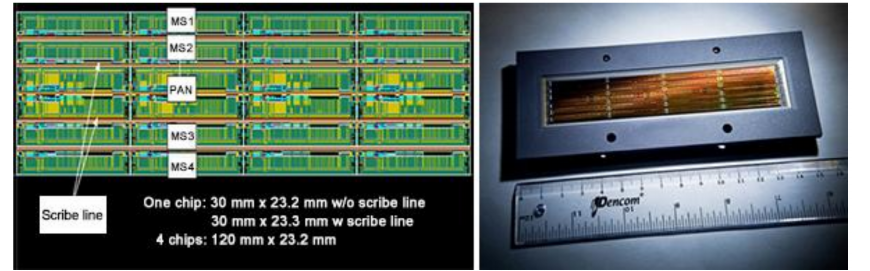
Figure 2. The naked complementary metal oxide semiconductor (CMOS) integrated circuit (IC) chip ( left ) and CMOS IC chip package ( right ) for the FS-5 RSI sensor. The CMOS IC is a single chip with dimensions of 120 mm by 23.2 mm, connecting four system-on-chips (SoC). Each SoC is composed of five image-sensing lines. The multispectral image sensing lines consists of 6000 pieces of 20- µ m pixels, while the panchromatic image sensing line consists of 12,000 pieces of 10- µ m pixels [5].